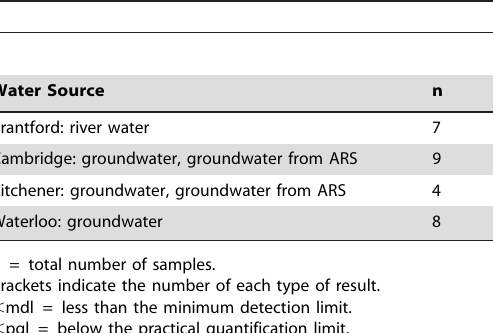
Table 2. Concentration of artificial sweeteners in municipal water collected from household